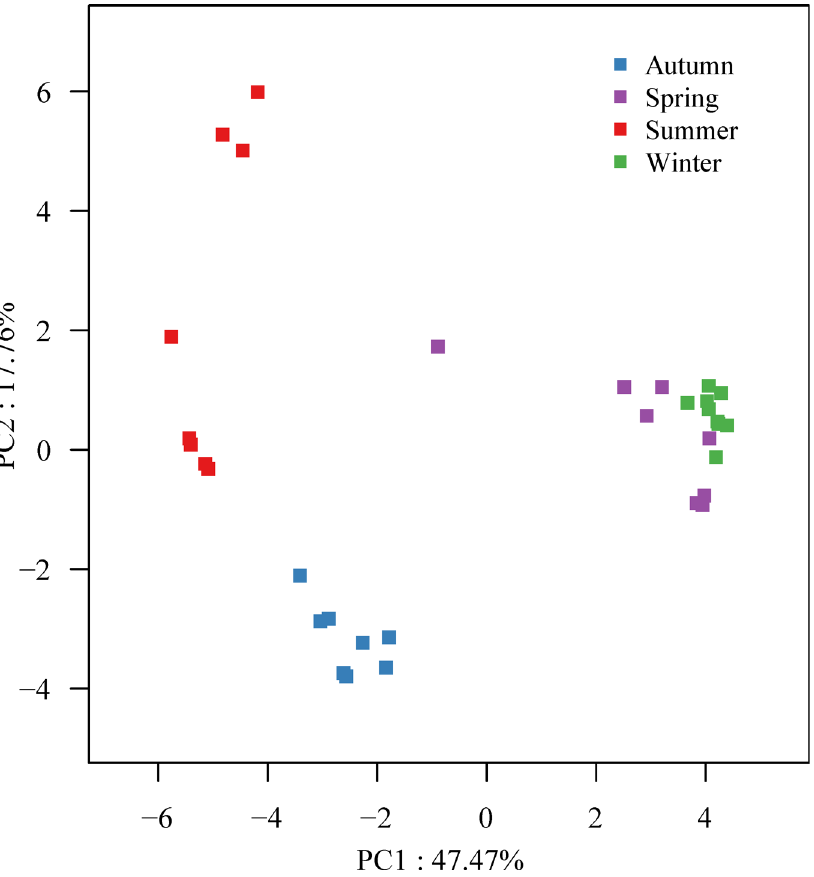
Fig 3. Principal coordinates analysis (PCoA) of 33 activated sludge (AS) samples by Bray-Curtis similarity coefficient. It was measured via 3% cutoff OTUs information. The dots were signed with different colors according to sampling